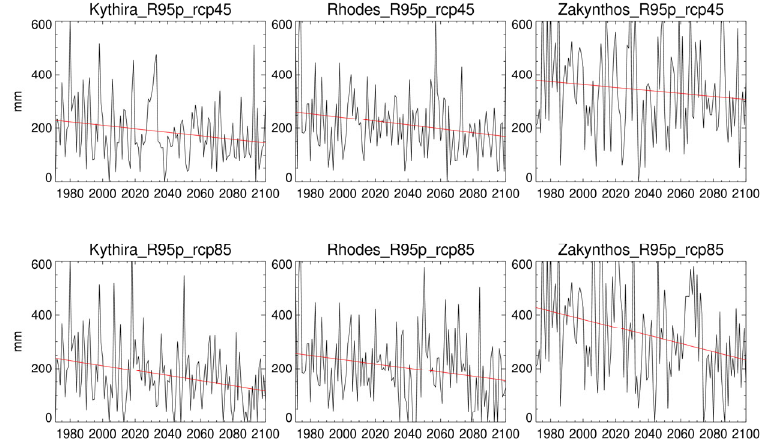
Figure 11. Annual total precipitation from days with precipitation exceeding the 95th percentile (R95p) under both emission scenarios.